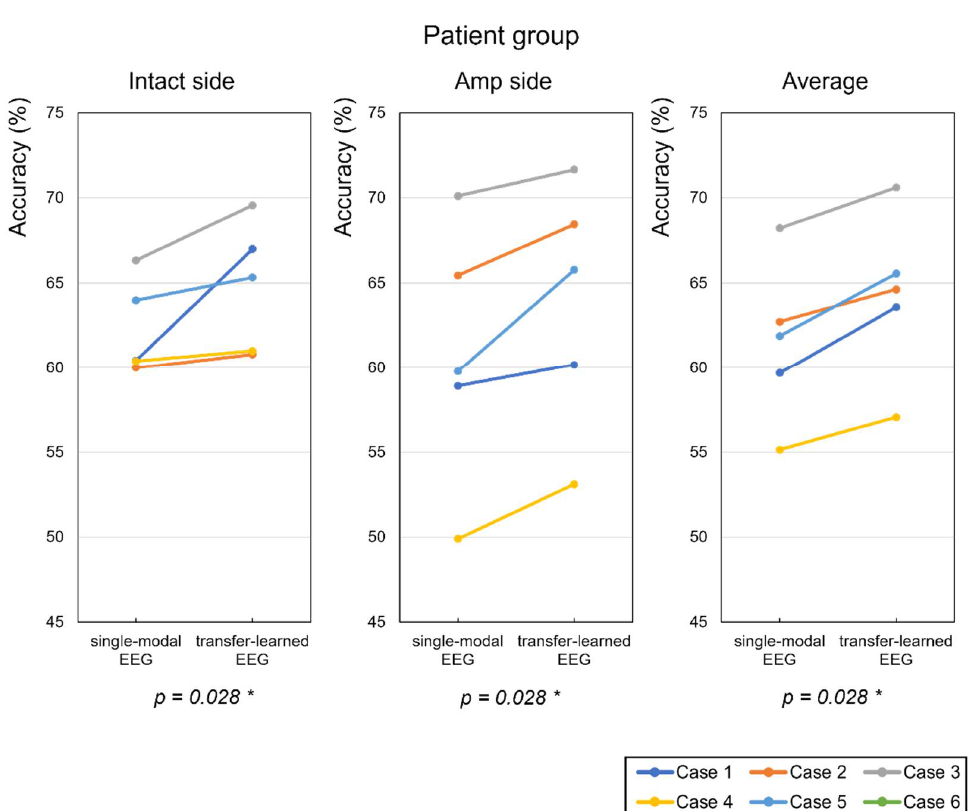
Figure 10. Classification accuracies for wrist dorsiflexion and volar flexion, wrist radial deviation and ulnar deviation, and hand grasping and opening, as performed by each amputated subject (%). “Intact side” refers to the accuracy result for the intact arm, and “Amp side” to that for the amputated arm. * p -value between single-modal EEG and transfer-learned EEG by Wilcoxon signed-rank test.